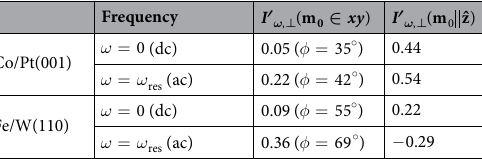
Table 2. Maximum amplitude of Hall currents for applied dc and resonant electric fields. When the magnetization is rotated in the xy plane (i.e., PHE symmetry), we also indicate in parenthesis the angle for which the current is maximum. The minus sign represents the change from the reference case of static Co/ Pt(001)